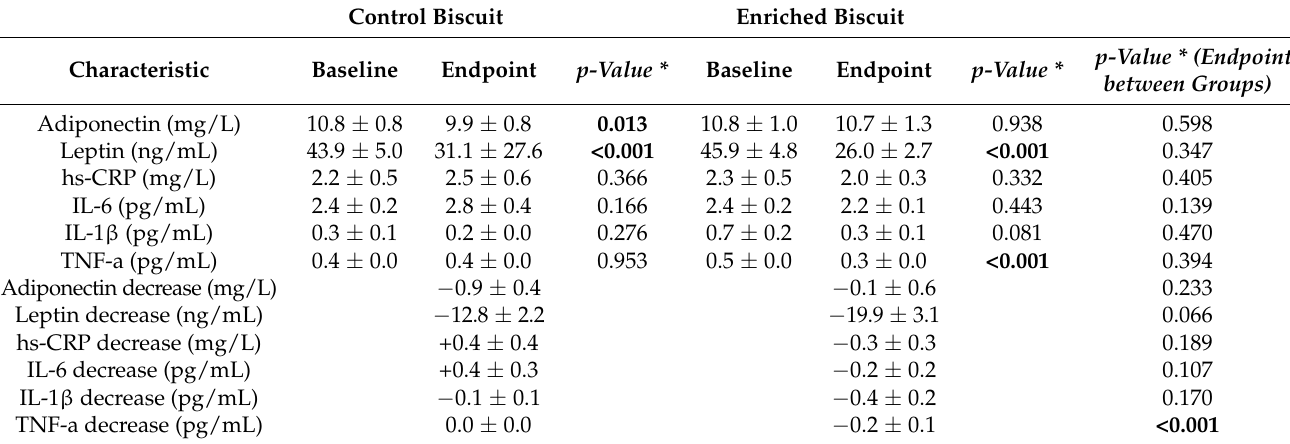
Table 5. Changes in levels of hormones and inflammatory markers for the two